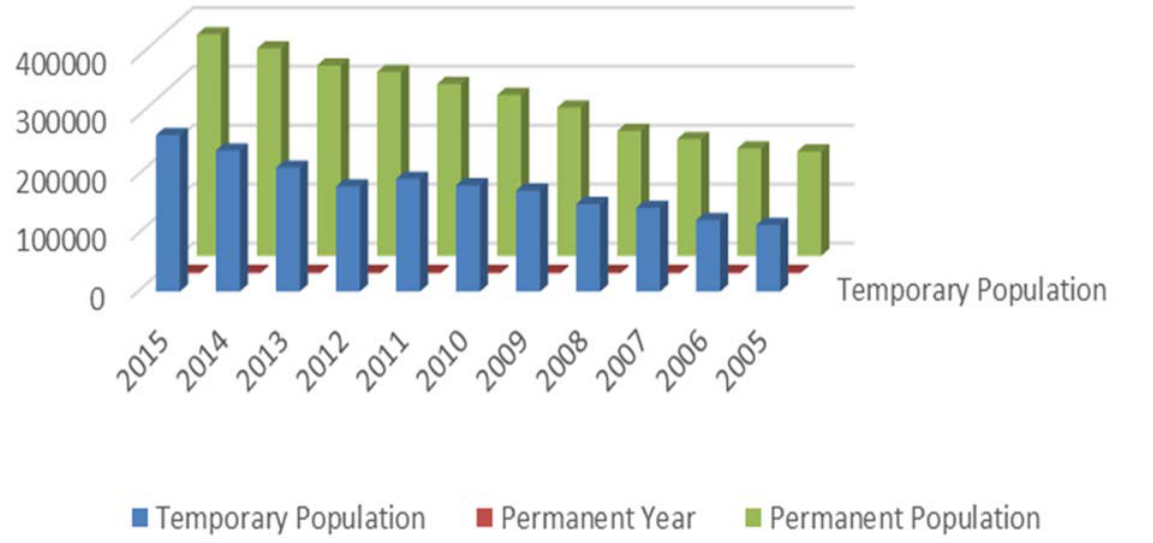
Fig. 2. Population dispersion (temporary and permanent)